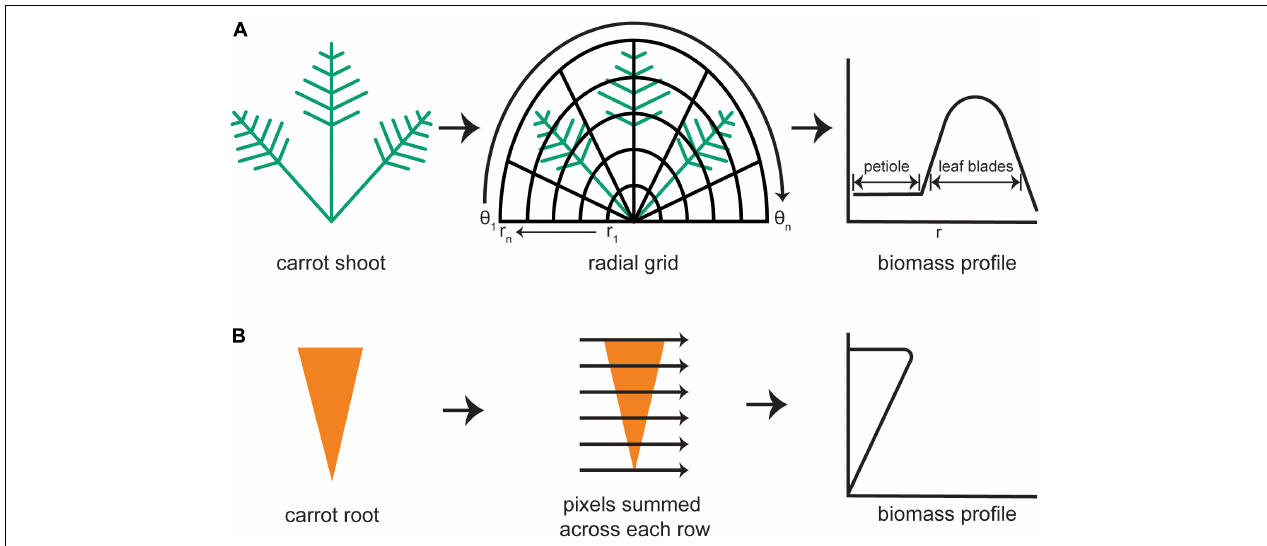
FIGURE 2 | Steps to generate biomass profiles for the shoot and root of individual carrot plants. (A) An image mask of a carrot shoot is superimposed with half of an elliptical grid. Holding each radius ( r ) of the grid constant, the image mask is integrated along each angular sweep ( θ ) to produce a shoot biomass profile with defined regions belonging to the petioles and to the leaf blades. (B) For the carrot root mask, pixels are summed across each row to produce a root biomass profile.